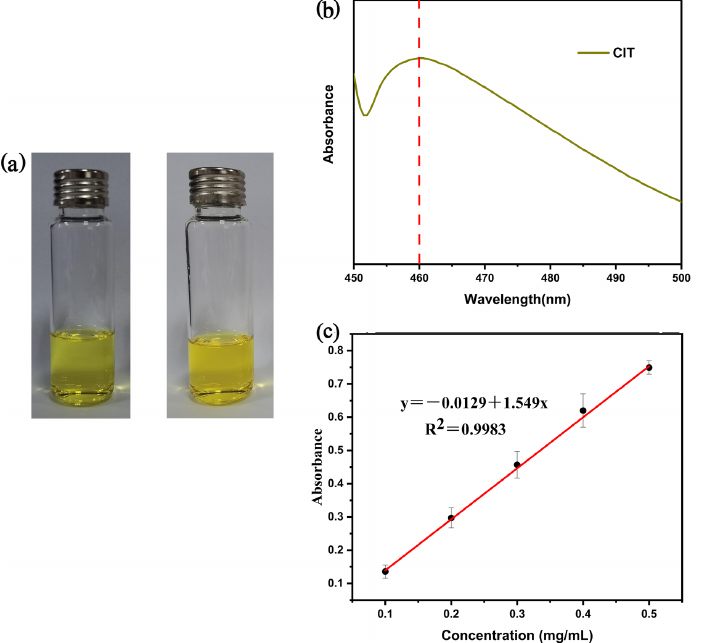
Figure 5. ( a ) The color reaction between blank sample and CIT; ( b ) UV-Vis absorption spectra between 450 and 500 nm; and ( c ) the standard curve of